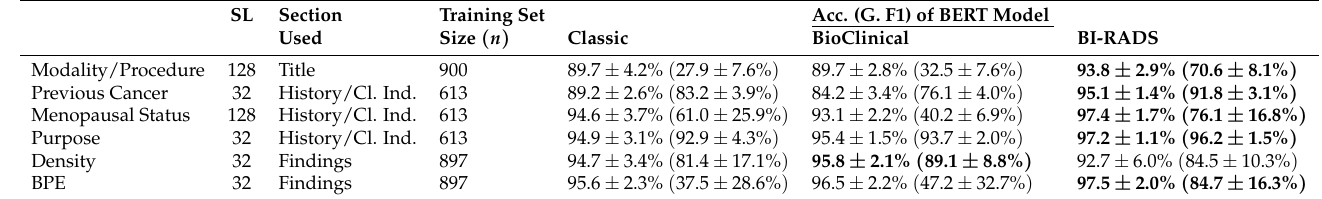
Table 5. Results of 5-fold cross validation field extraction with section segmentation, evaluated with average accuracy with standard deviation (Std.Dev.) and average G.F1 with standard deviation (Std.Dev.) across all 5